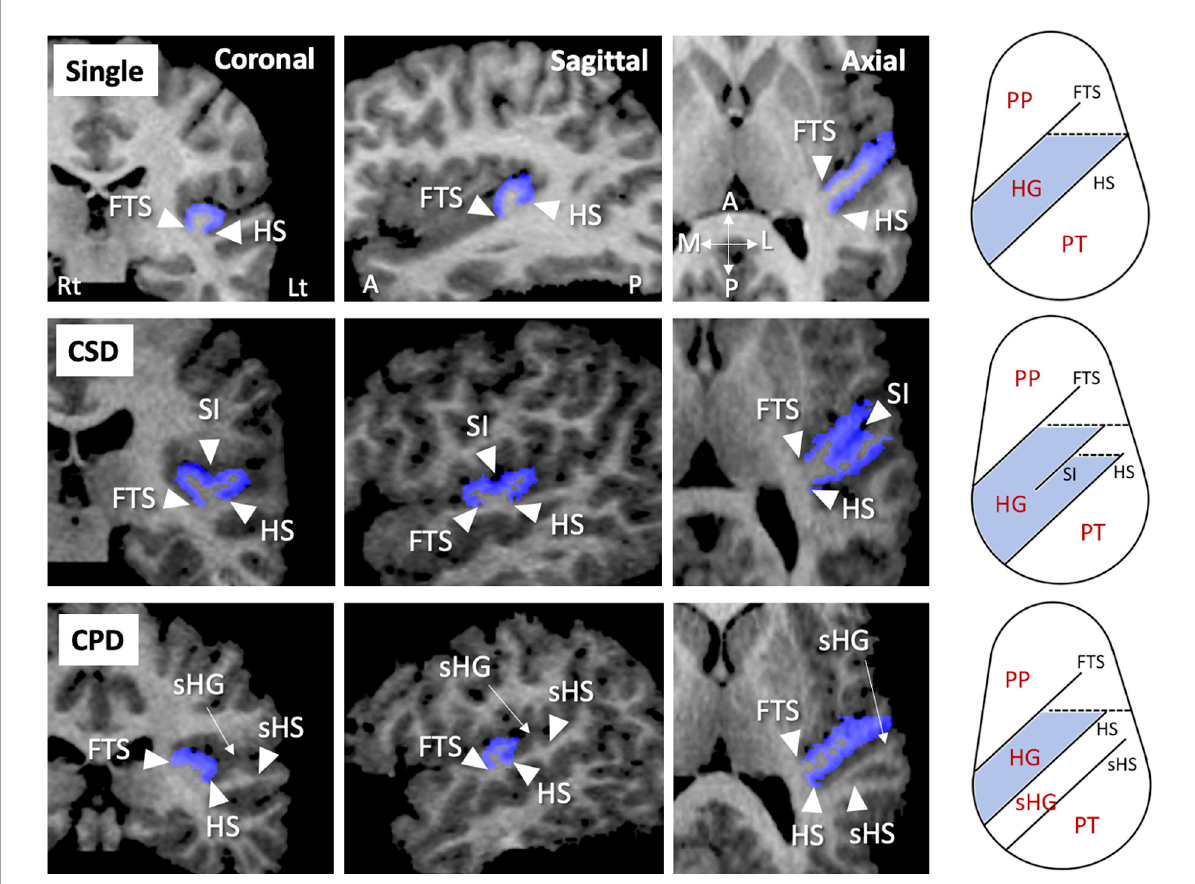
FIGURE1 Sample MR images of different gyrification pattern in the Heschl’s gyrus (HG) (colored in blue). These HG patterns have been demonstrated also in our previous publications (22–26). A, anterior; CPD, complete posterior duplication; CSD, common stem duplication; FTS, first transverse sulcus; HS, Heschl’s sulcus; L, lateral; Lt, left; P, posterior; M, medial; PP, planum polare; Rt, right; sHG, second Heschl’s gyrus; sHS, second Heschl’s sulcus; SI, sulcus